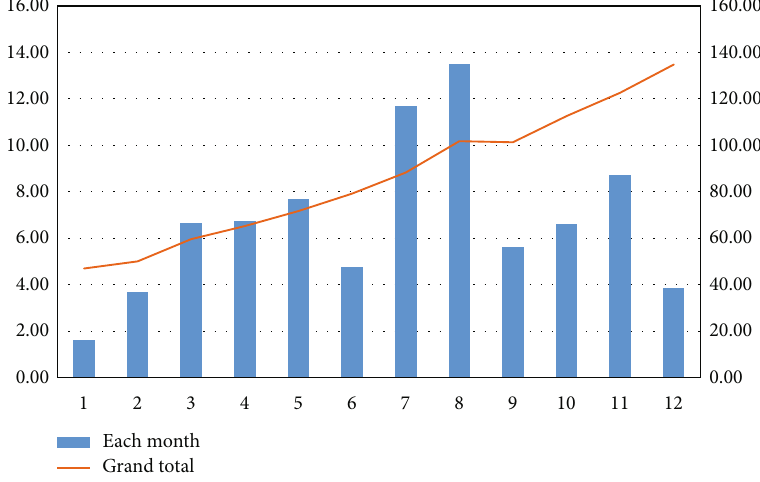
Figure 7: Statistical proportion of fi nancing amount of each crowdfunding platform in